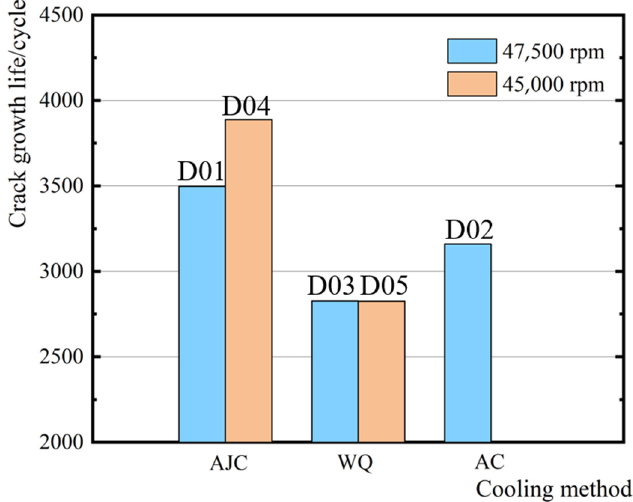
Figure 22. Crack growth life of discs with different cooling methods.